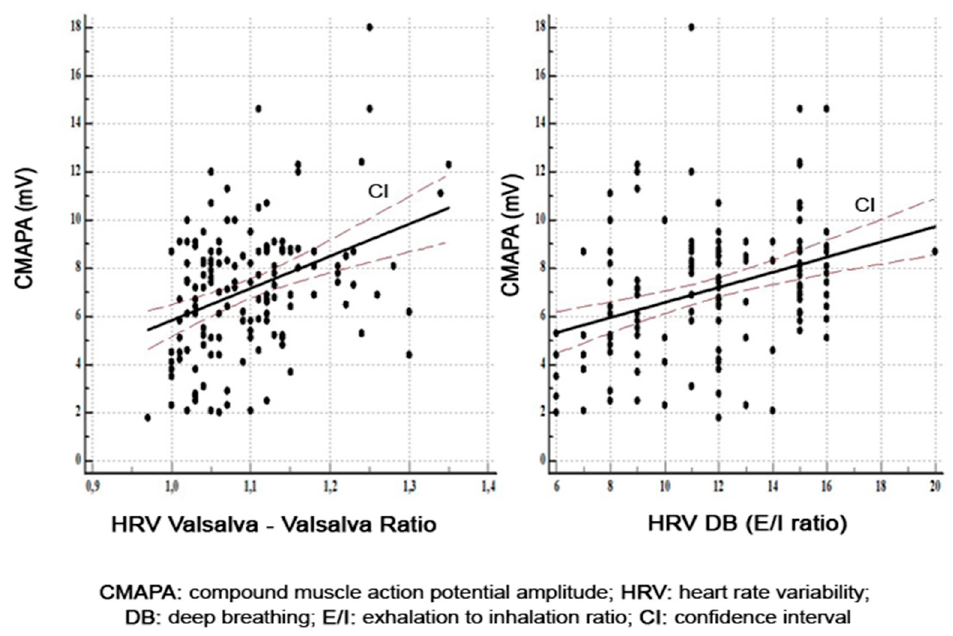
Figure 1. Correlations between amplitude of motor response in median nerves and HRV Valsalva and HRV DB.